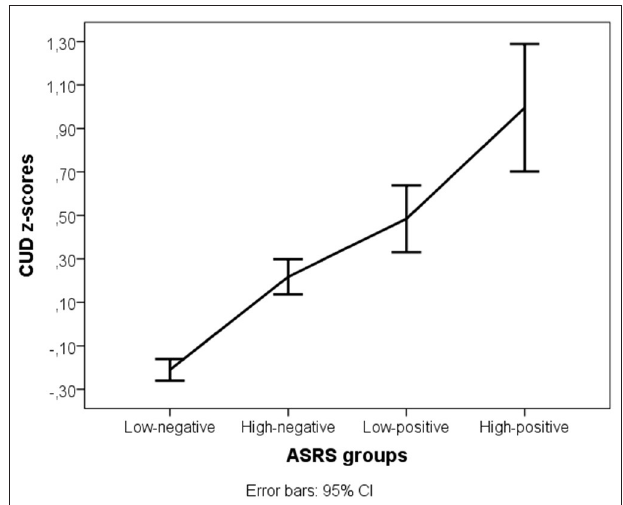
FIGURE 1 | Caffeine use disorder symptom z-scores in the four ADHD groups. ASRS, Attention-deficit/hyperactivity disorder symptoms; CUD, Caffeine Use Disorder